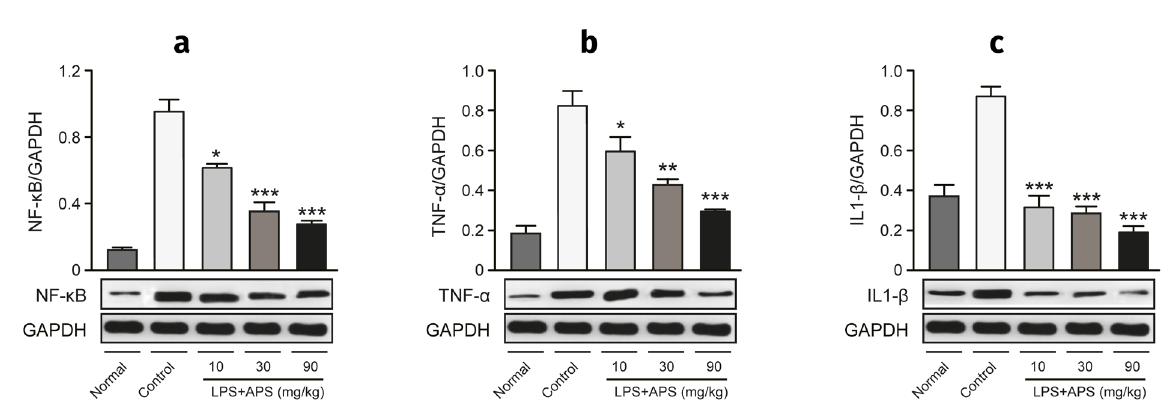
Figure 5. Chronic treatment of APS prevented the overtraining induced myocardial inflammation. The protein expression levels of (a) NF-κB, (b) TNF-α and (c) IL-1βwere detected via WB method. * = p < 0.05, ** = p < 0.02, *** = p < 0.001 vs. saline-treated excessive exercise rat group. Values represent mean ± SD of 8 independent